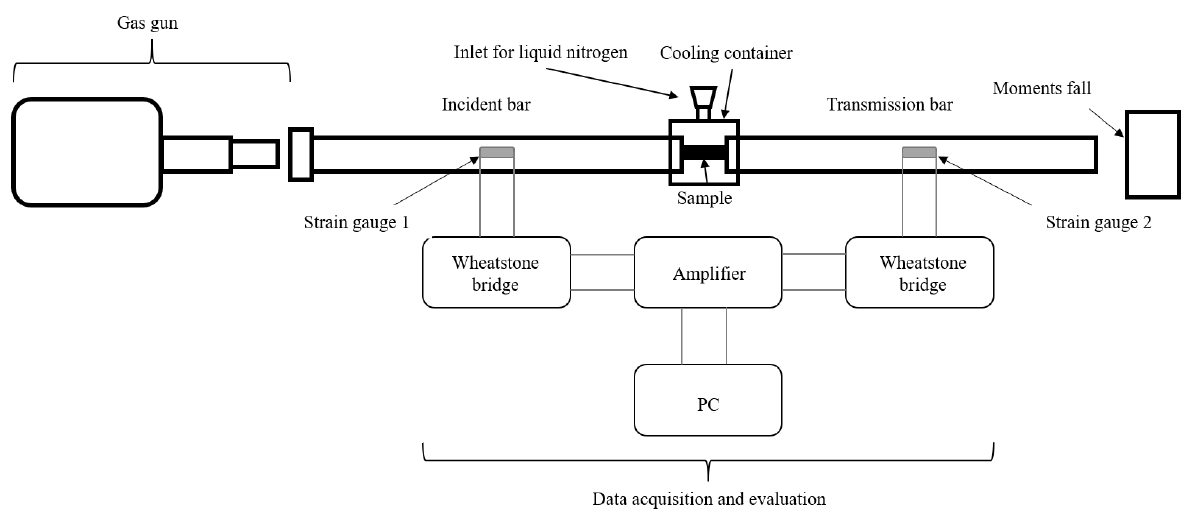
Figure 1. Drawing of the experimental setup of the compressive and cutting test; for the tensile test, the gas gun was positioned on the incident bar, cf. Figure